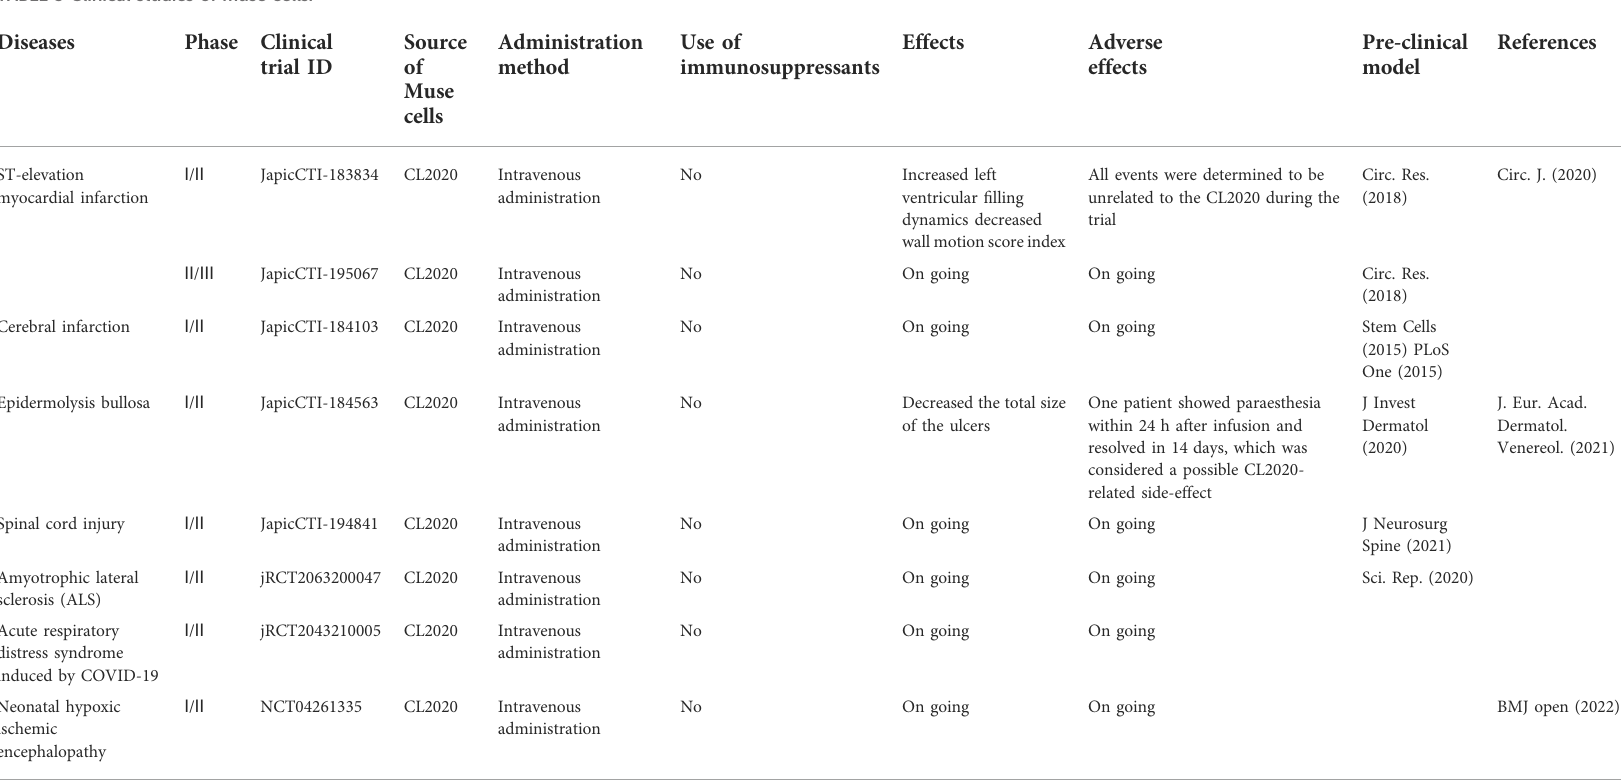
TABLE 3 Clinical studies of muse